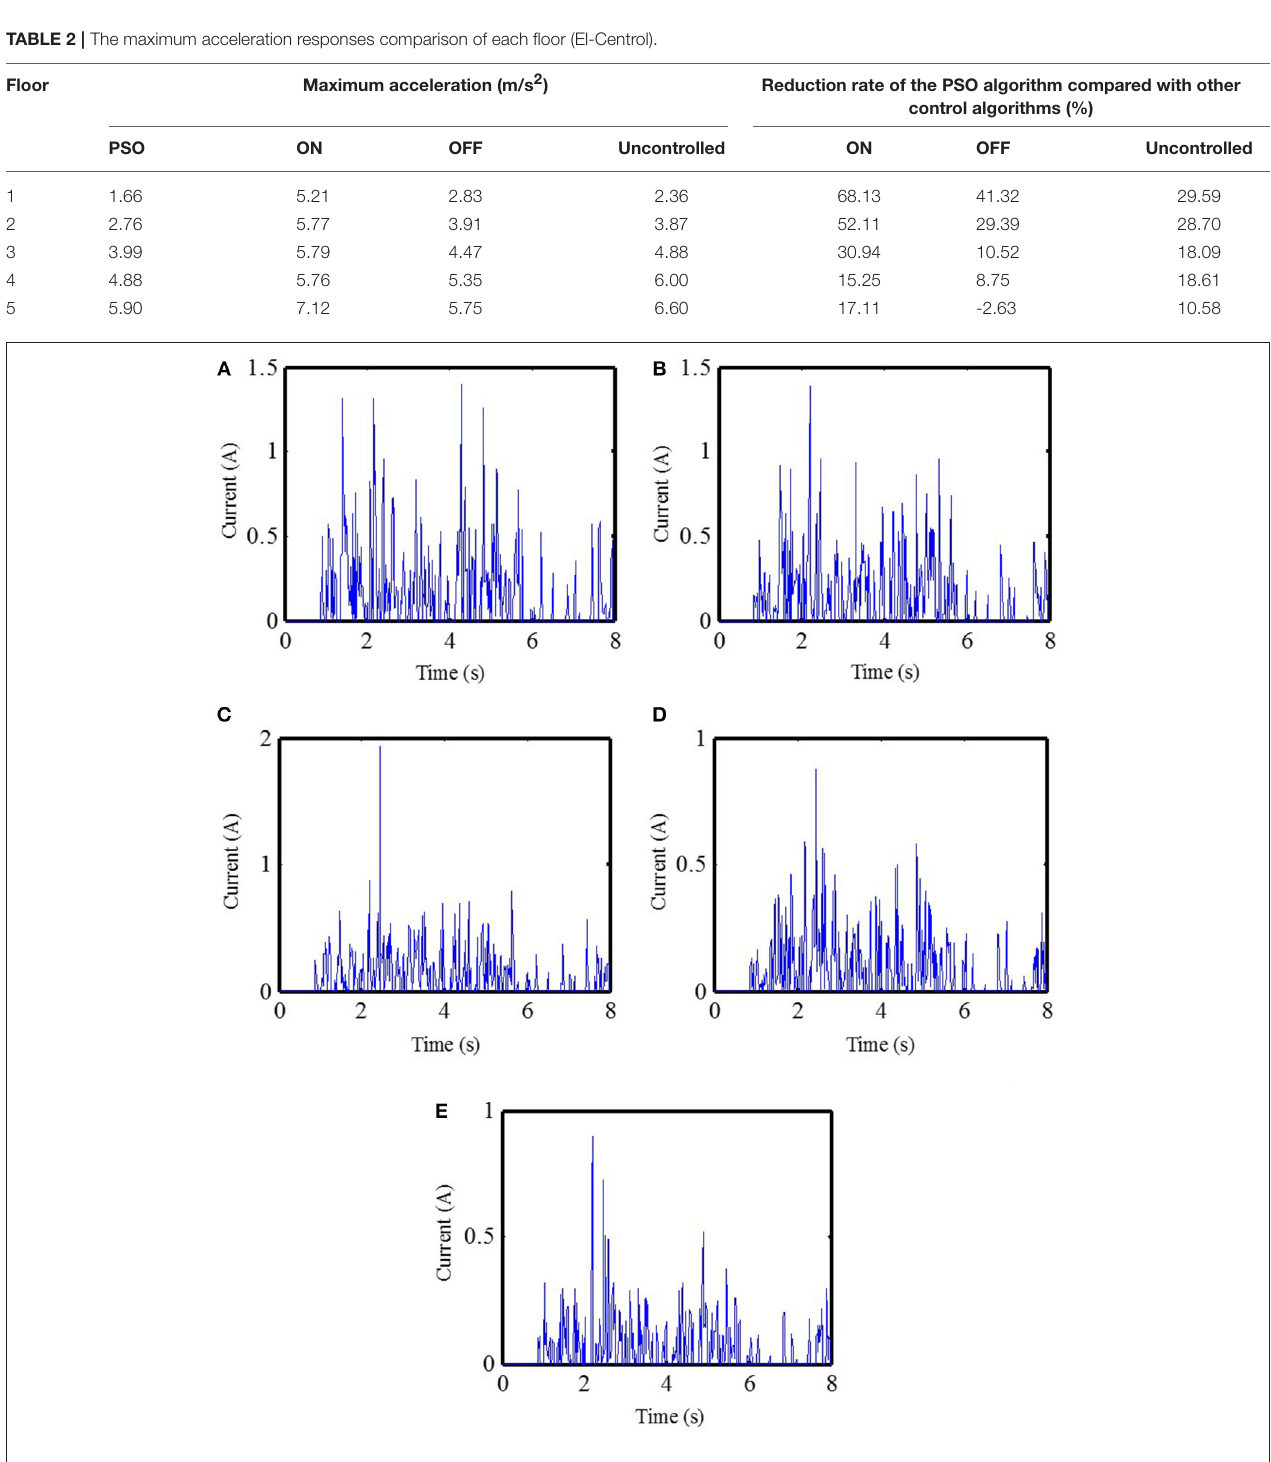
FIGURE 8 | Control currents of MR dampers of each floor of the PSO control structure (El-Centrol). (A) The 1st floor control currents. (B) The 2nd floor control currents. (C) The 3rd floor control currents. (D) The 4th floor control currents. (E) The 5th floor control currents. is effectively reduced by − 30.40% compared to that of the uncontrolled structure, 14.8 mm. But under the PSO algorithm, the structural 5th floor maximum acceleration response,